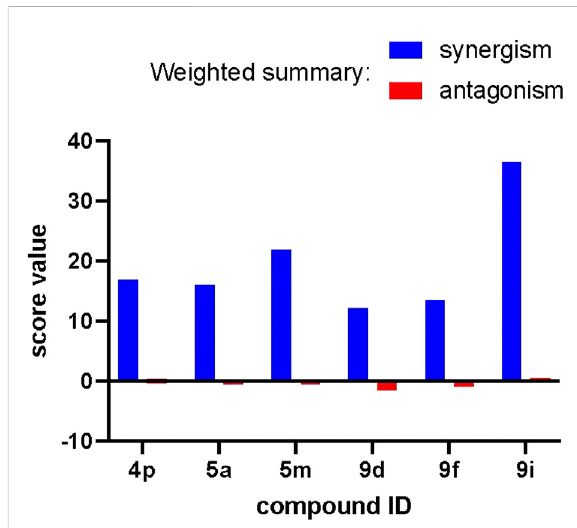
FIGURE 7 Strong synergism between our compounds and docetaxel in the anti-proliferative assays. Weighted summary synergism and antagonism scores obtained for different compounds after analysis with the COMBENEFIT software are